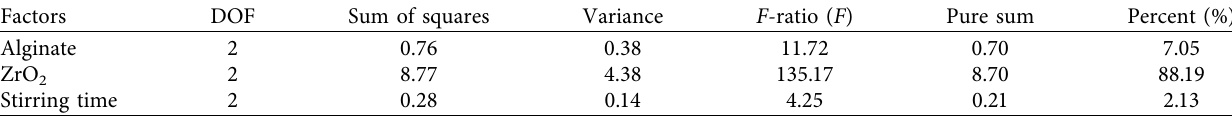
Table 4: Te analysis of variance of factors afecting the survival rate of Streptococcus mutans. Factors